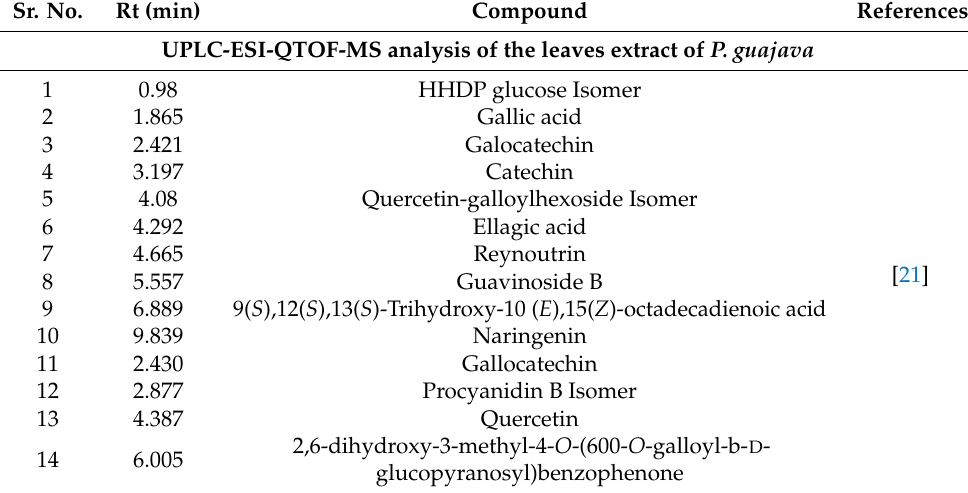
Table 2. Phytochemicals identified through LCMS studies of the Fresh Leaf of P. guajava (A). Sr. No. Rt